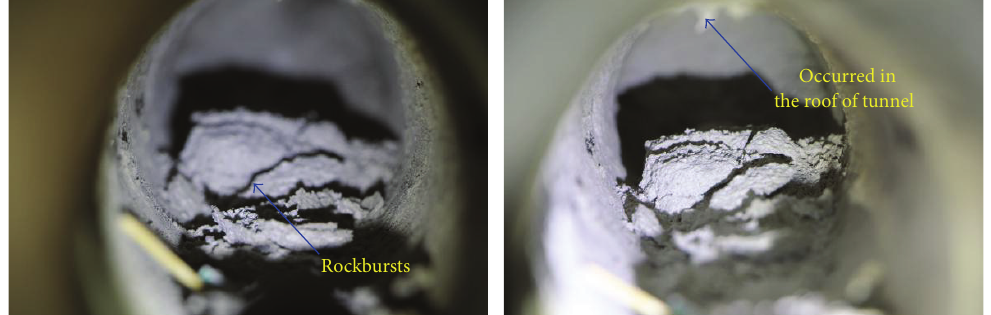
Figure 15: Rockbursts in model